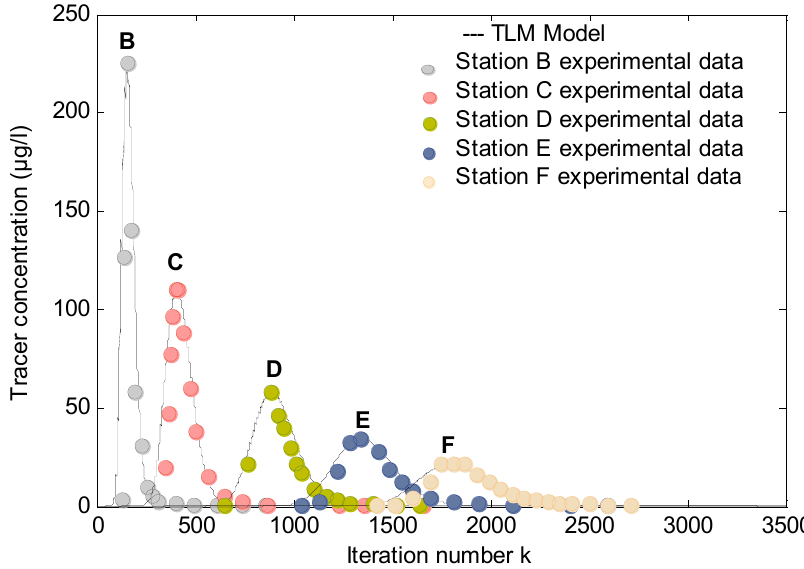
Figure 4. TLM modeling and experimental data of Atkinson and Davis. The total tension